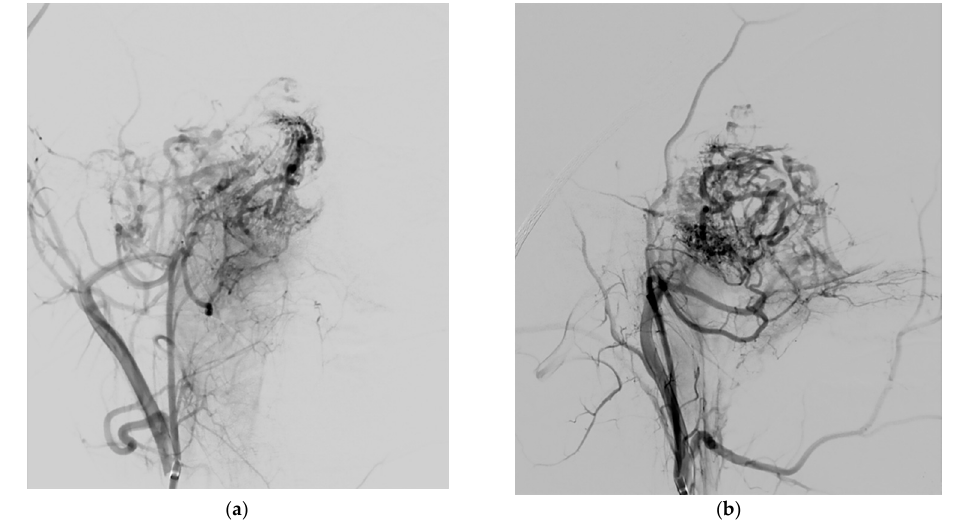
Figure 2. Preoperative DSA: selective catheterization of proximal ECA. Posteroanterior (PA) ( a ) and laterolateral (LL) ( b ) views of the JNA with major feeders from sphenopalatine branches of the distal internal maxillary artery (IMA) and from the ascending pharyngeal artery (APhA).